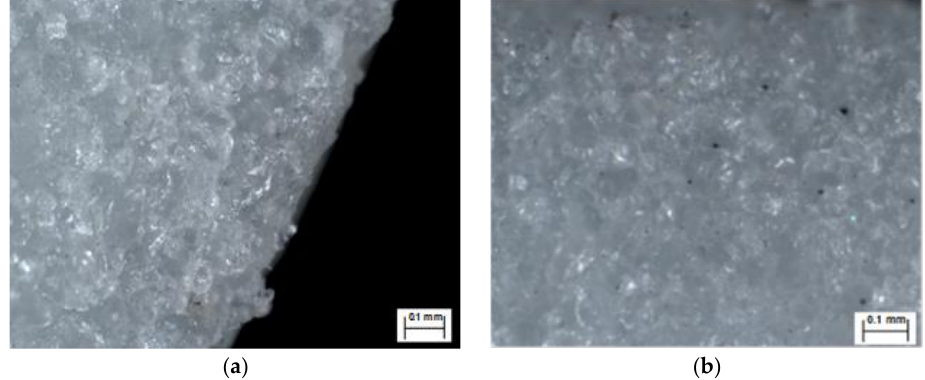
Figure 6. Scanning electron micrographs for 10% blend of: ( a ) the break edge; and ( b ) the material surface structure; visible black patches represent inclusion of diatomaceous earth in the blend.